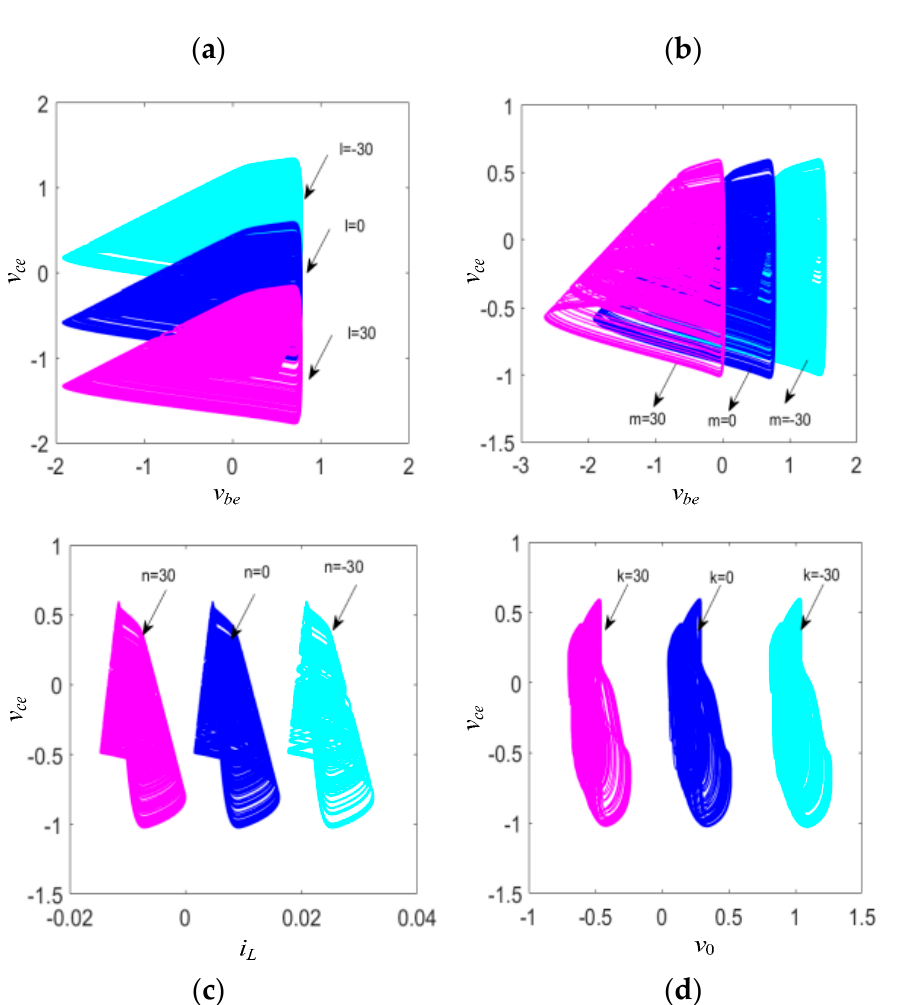
Figure 14. Offset boosting of chaotic attractors for varying the control parameter. ( a ) l = 0 and l = ± 30, ( b ) m = 0 and m = ± 30, ( c ) n = 0 and n = ± 30 and ( d ) k = 0 and k = ± 30. In order to analyze the multistability, the novel non-invasive method of offset [43] was exploited. The parameter values are the same as in Section 4.1 and R = 966. Let offset boosting be applied to variable x , as shown below: